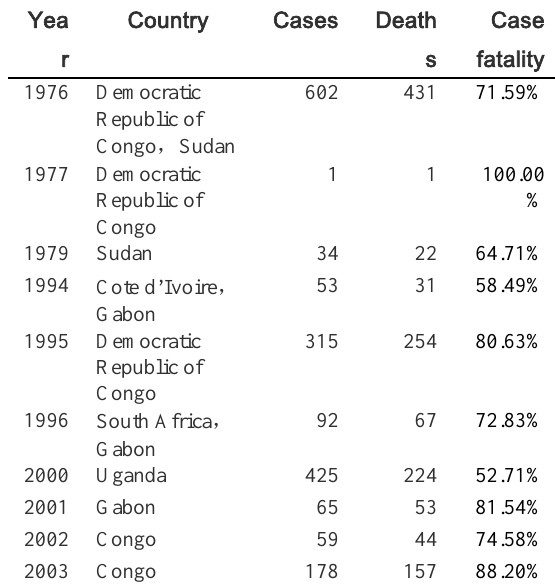
Table 1. The historical Statistics of